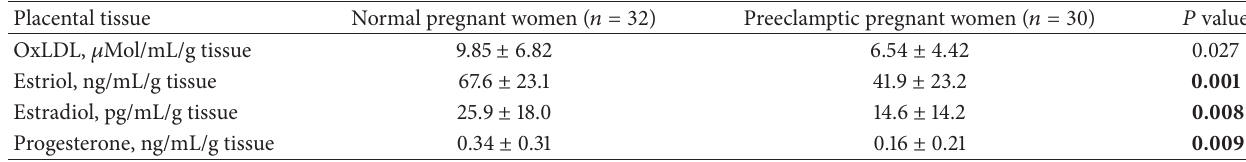
Table 2: Levels of OxLDL, estriol, estradiol, and progesterone in the placenta of preeclamptic and normal pregnant women. Placental tissue